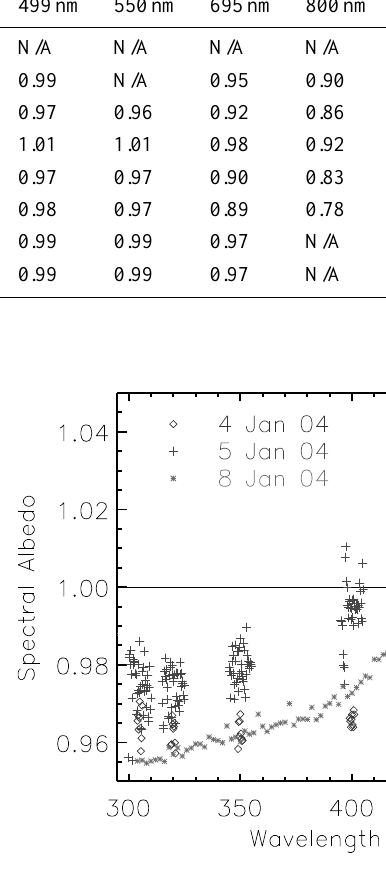
Fig. 4. Daily mean spectral albedo measured at Neumayer on three selected days. The maximum value is reached at about 500nm. The albedo decreases slightly towards shorter wavelengths. The de- crease in albedo for longer wavelengths becomes more pronounced in the infrared for wavelengths greater than 800nm.